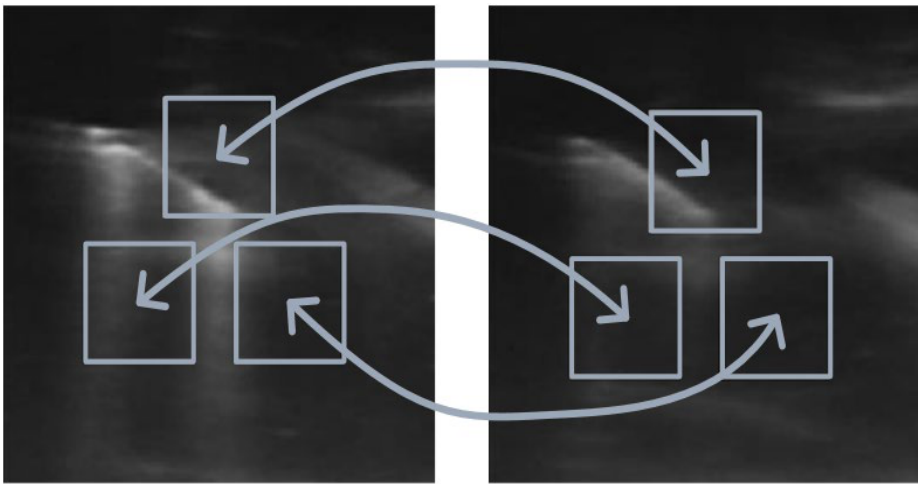
Figure 14. Three groups of 64 × 64 image blocks of two consecutive B-scans.